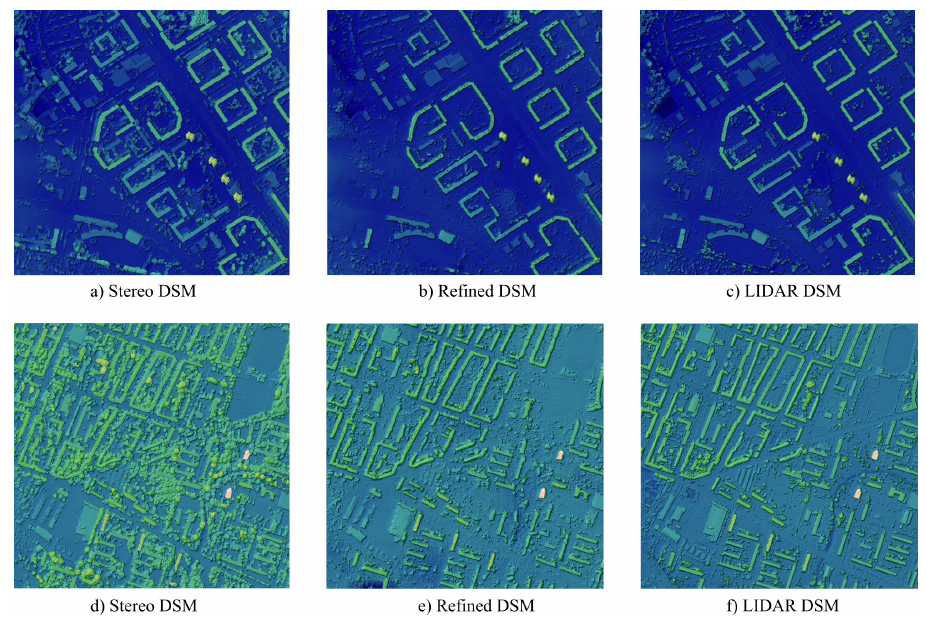
Figure 2. Examples of the generated DSM with refined 3D buildings